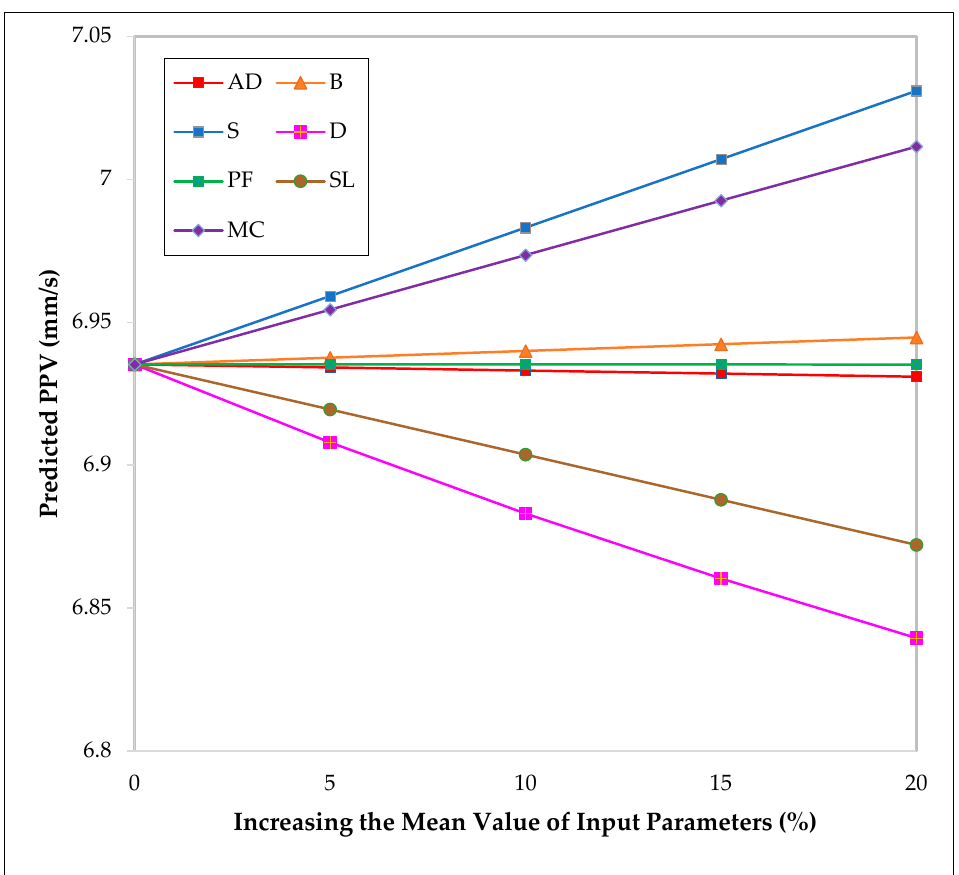
Figure 8. The Input Parameters and PPV Relationship’s Strength.